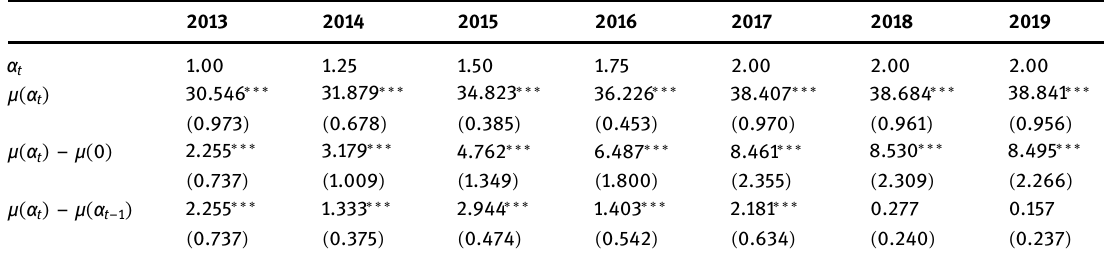
Table 2: E ff ect of pay - for - performance on the mean quality